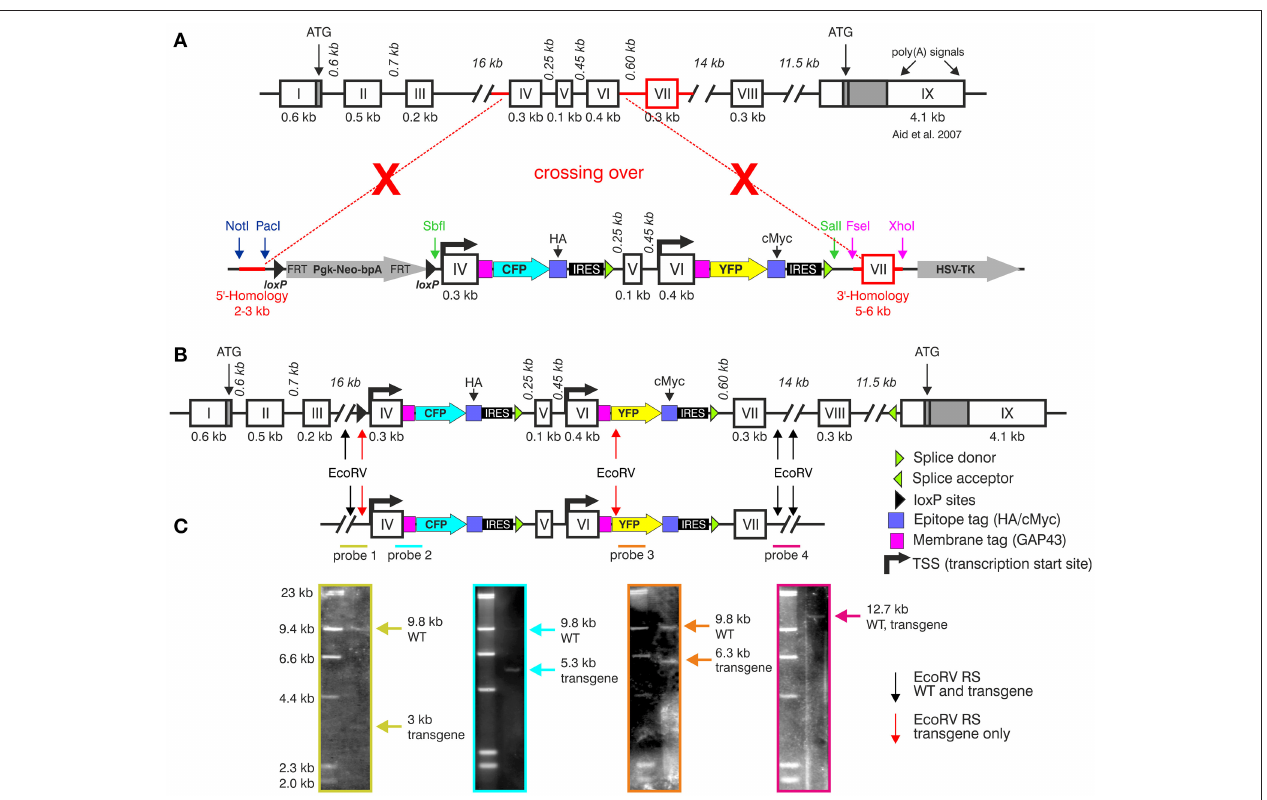
FIGURE 3 | Generation of the BLEV reporter mouse. (A) Schematic drawing of the Bdnf gene (Aid et al., 2007) and the BDNF vector construct used for homologous recombination. Crossing-over events are indicated by red dotted lines and crosses. The 5’ and 3’ parts for homologous recombination are marked in red. (B) Bdnf gene construct depicting insertion sites of the BLEV construct. Arrows indicate the EcoRV restriction sites (RS) used for Southern blot. Black arrows indicate EcoRV RS cutting the WT and the transgenic sequence, red arrows cut only the transgenic sequence. (C) Southern blot of a positively transfected ES cell clone. The positions of the four Southern blot probes (colored lines: green, blue, orange, and pink) are shown under the schematic drawing of the BDNF construct. Probe 1, specific for the 5 ′ -end: WT band 9.8kb, transgenic allele 3kb; probe 2, covering parts of exon-IV transgene: WT band 9.8kb, transgenic allele 5.3kb; probe 3, covering parts of the exon-VI transgene: WT band 9.8kb, transgenic allele 6.3kb; probe 4, specific for the 3 ′ -end: WT and transgenic allele 12.7kb. Note that the size of the drawn construct and probes does not reflect the real size of the DNA fragments obtained by Southern blot. For original Blots see Supplementary Figure 1